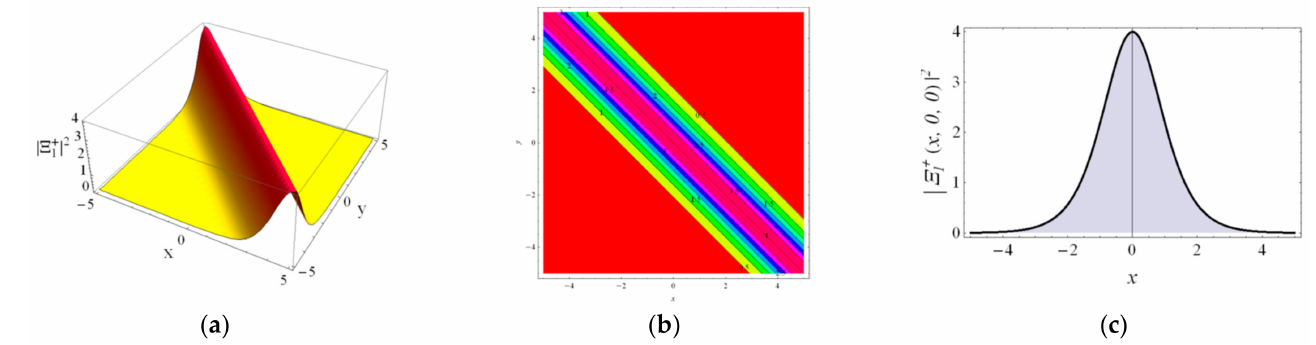
(cid:12) (cid:12) 2 with the parameters ε (cid:12) Ξ + (cid:12) 1